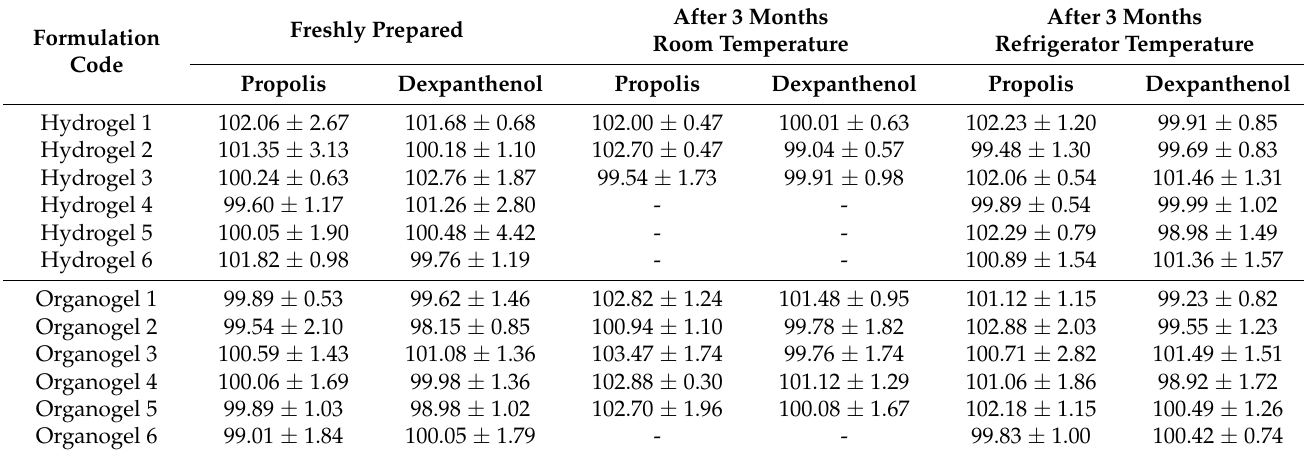
Table 4. Drug contents of hydrogels and organogels (mean ± SD).